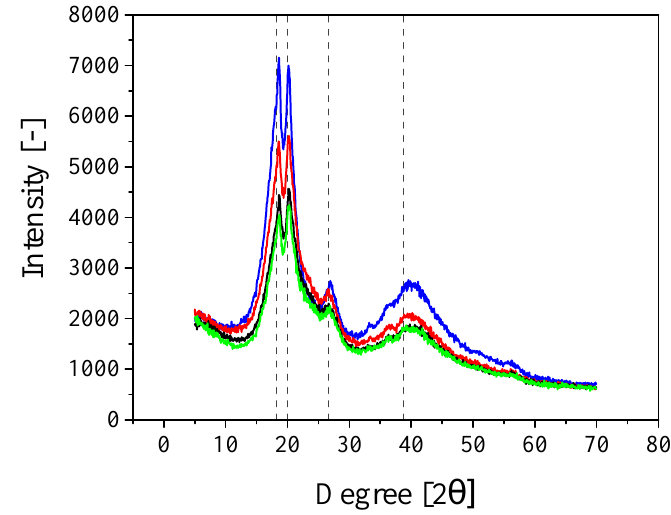
Figure 4. XRD of the composite gel obtained after one passage through the microchannel at different percentages of the fillers, silica NPs. Blue curve: PVdF-HFP; Red curve: PVdF-HFP + 10% SiO 2 ; Black curve: PVdF-HFP + 20% SiO 2 ; Green curve: PVdF-HFP + 30% SiO 2